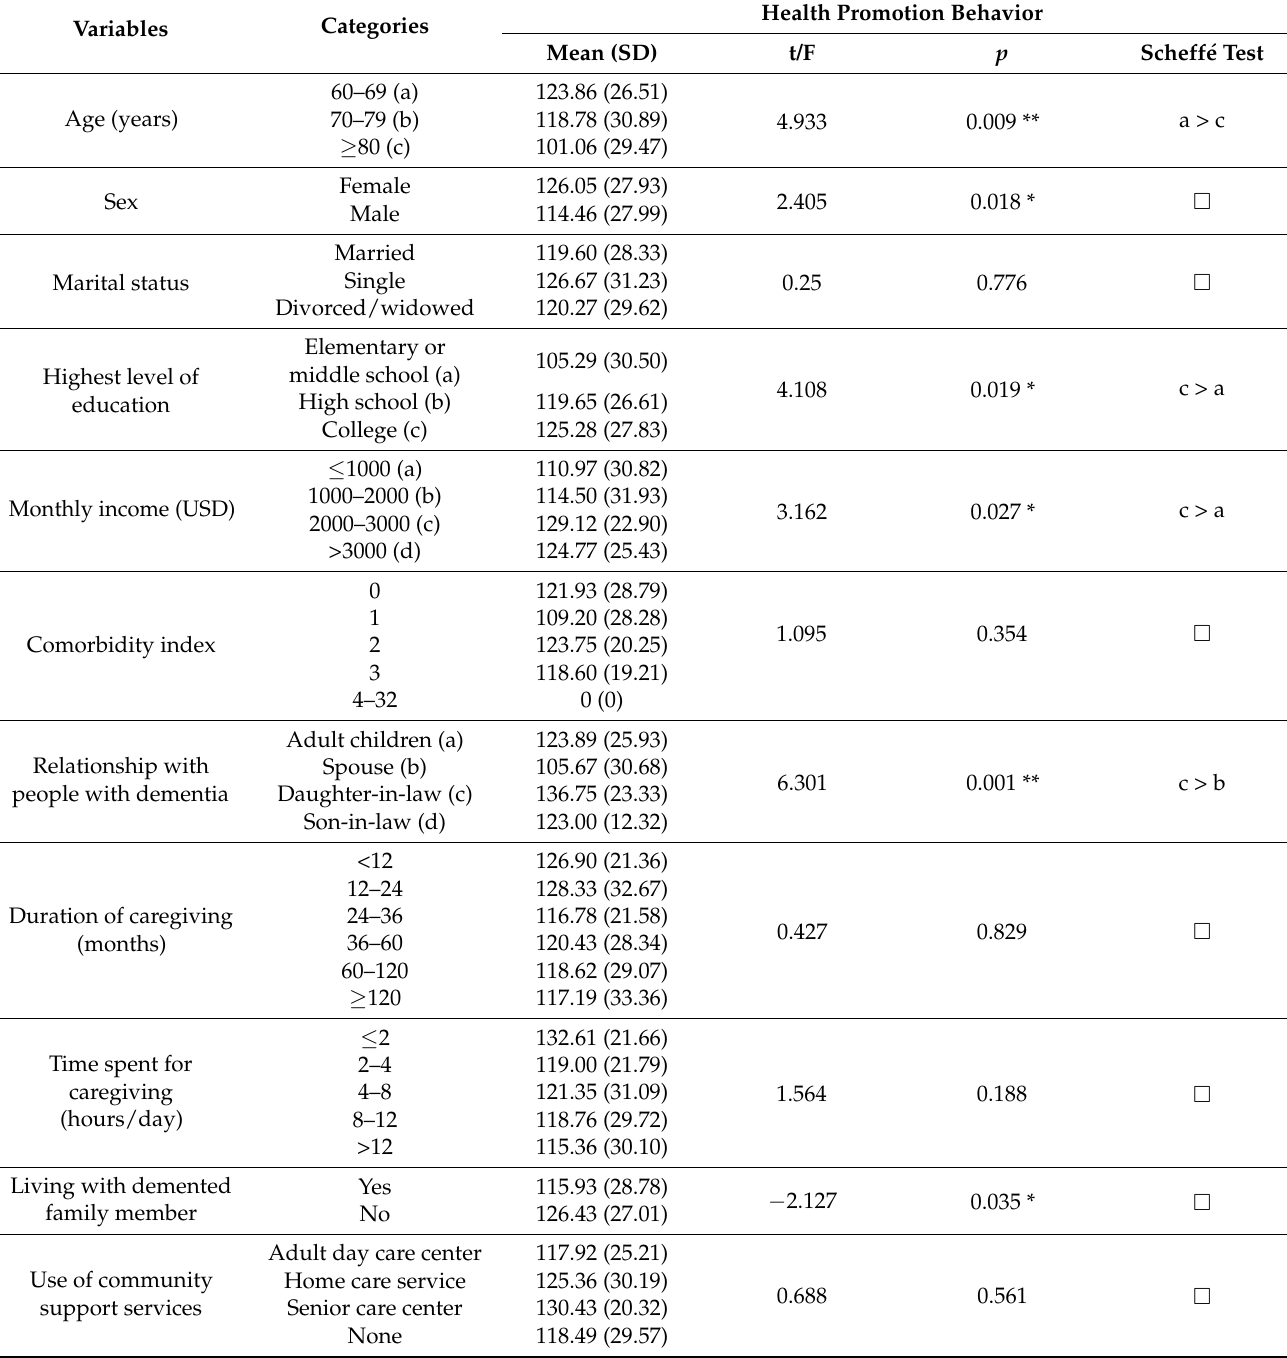
Table 2. Differences in health promotion behavior according to the sociodemographic and caregiver related characteristic ( N = 135).